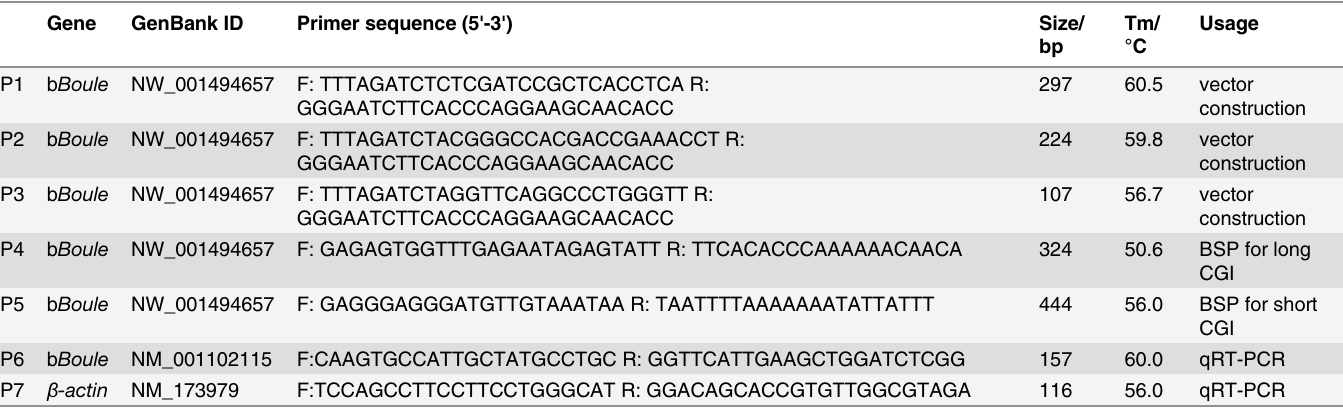
Table 1. The primers used in this study. Gene GenBank